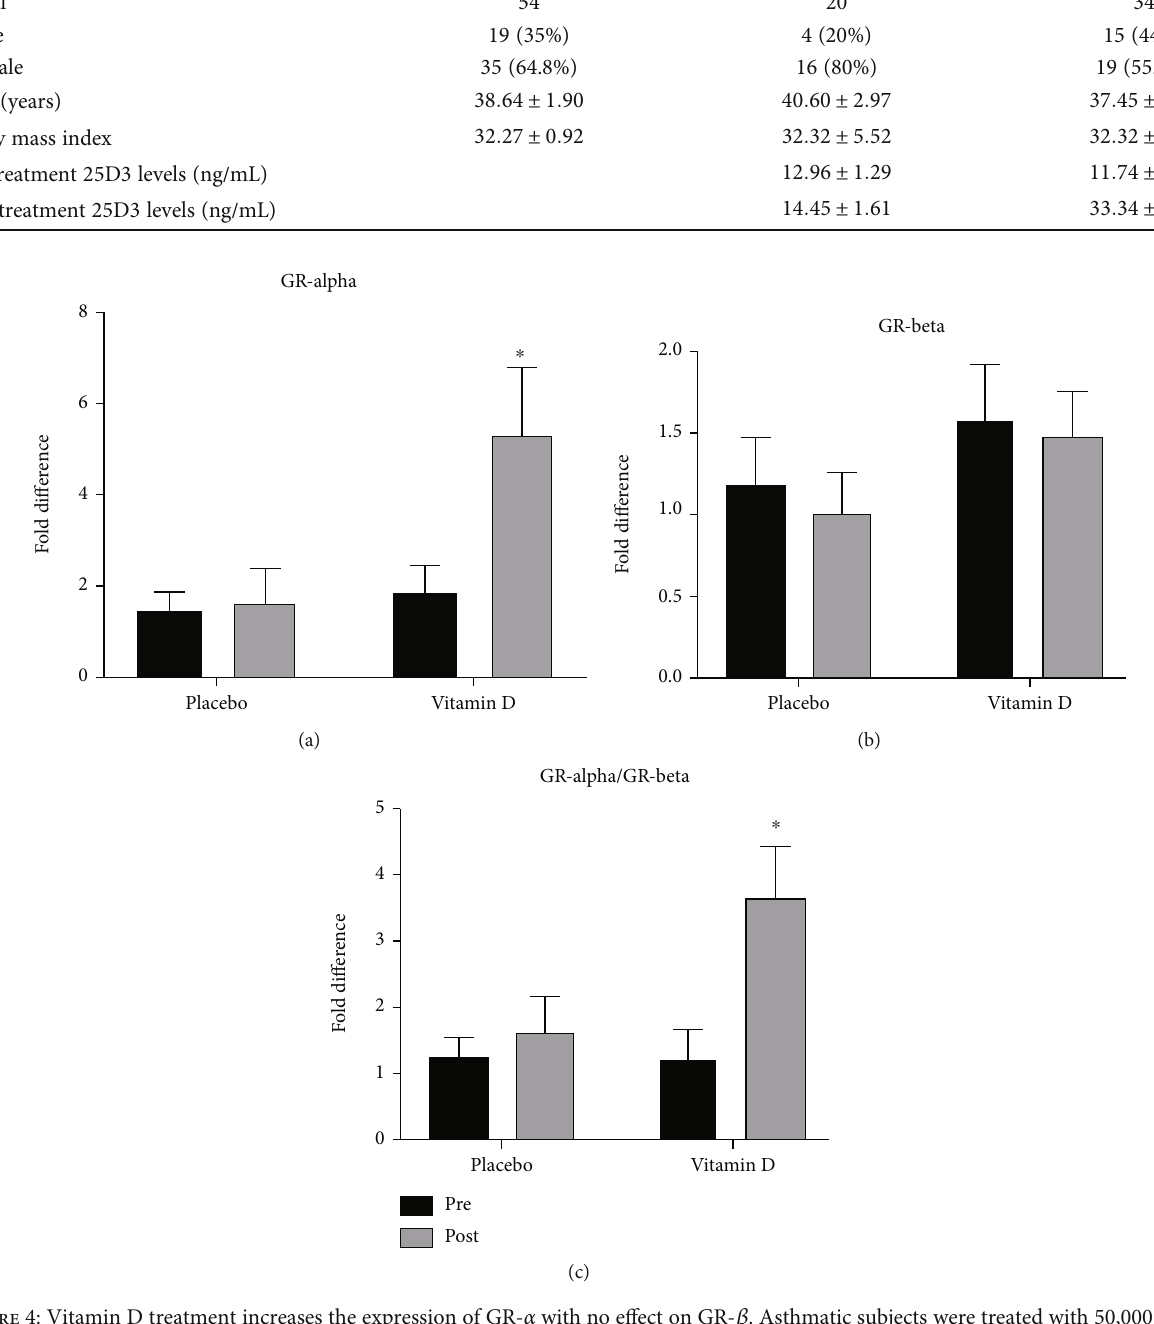
Figure 4: Vitamin D treatment increases the expression of GR- α with no e ff ect on GR- β . Asthmatic subjects were treated with 50,000IU of vitamin D orally or placebo for eight weeks. Blood specimens obtained prior to and following 8 weeks of treatment were analyzed for mRNA expression of (a) GR- α and (b) GR- β using RT-qPCR, and the ratio of (c) GR- α /GR- β was calculated. ∗ p < 0 : 05